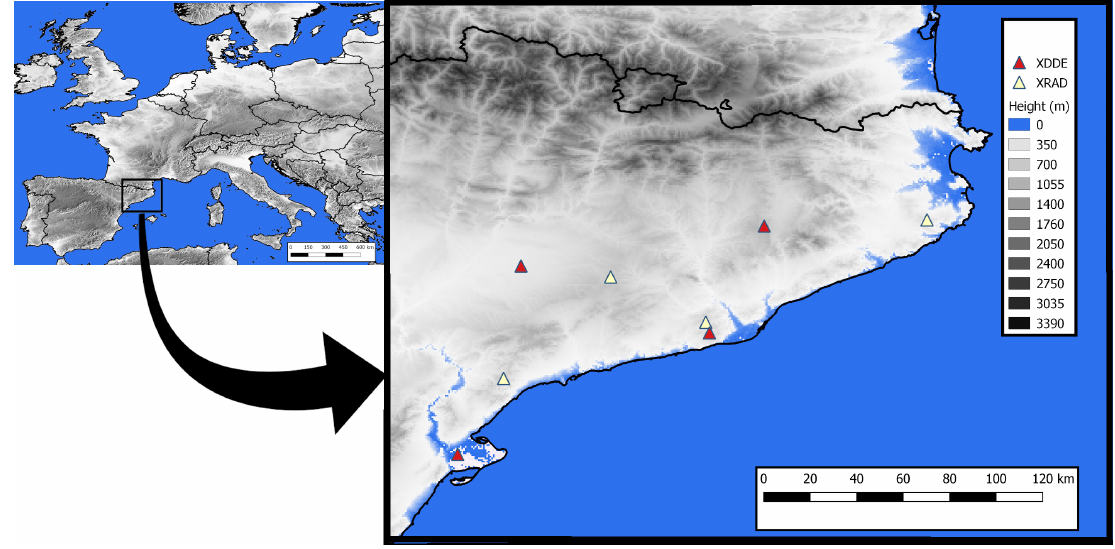
Figure 1. Geographic location of the area of study. ( Left ) European map with the region of interest marked with a black rectangle. ( Right ) Zoom of the region of interest showing the location of the elements of the LLS (red triangles) and of the XRAD (yellow triangles).